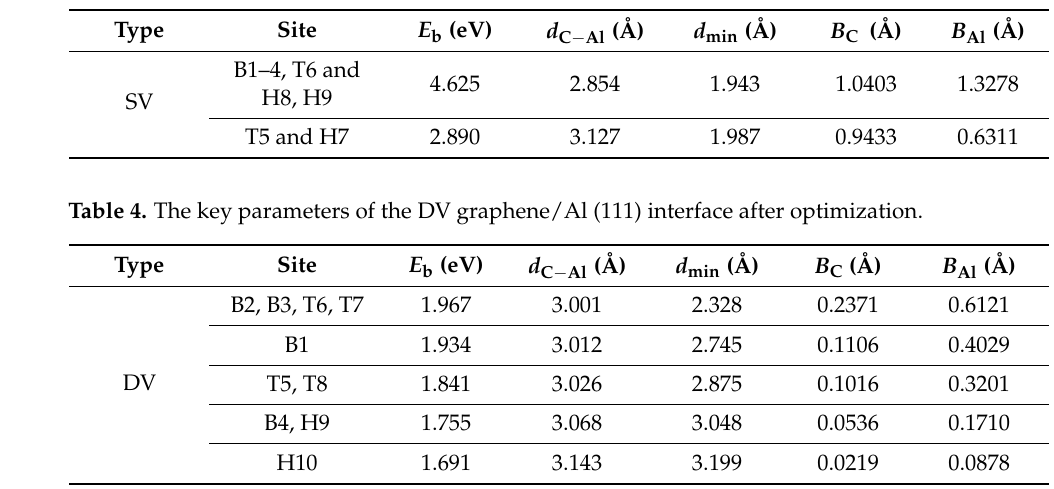
Table 3. The key parameters of the SV graphene/Al (111) interface after optimization.